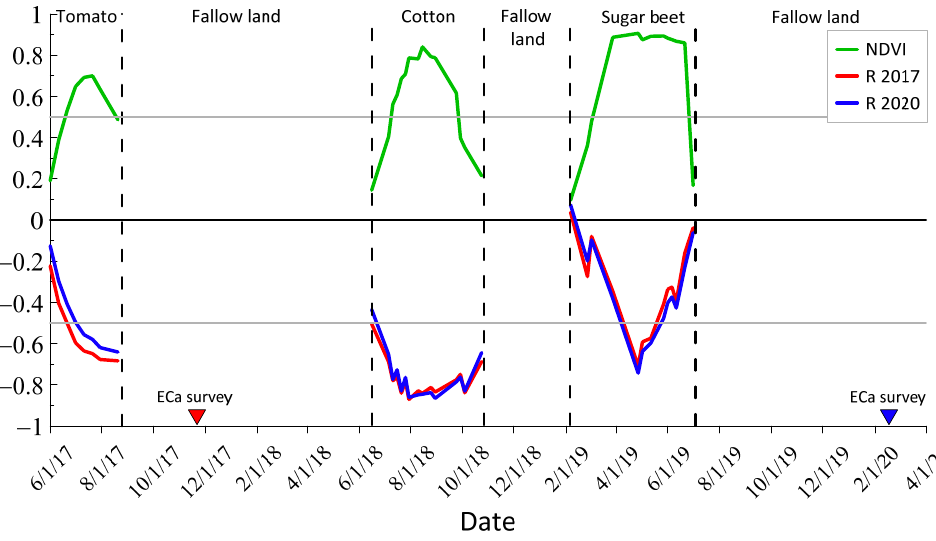
Figure 10. Evolution of mean NDVI and Pearson correlation coefficient (R) between NDVI and depth-specific EC at 0.9 m depth, measured in 2017 and 2020.